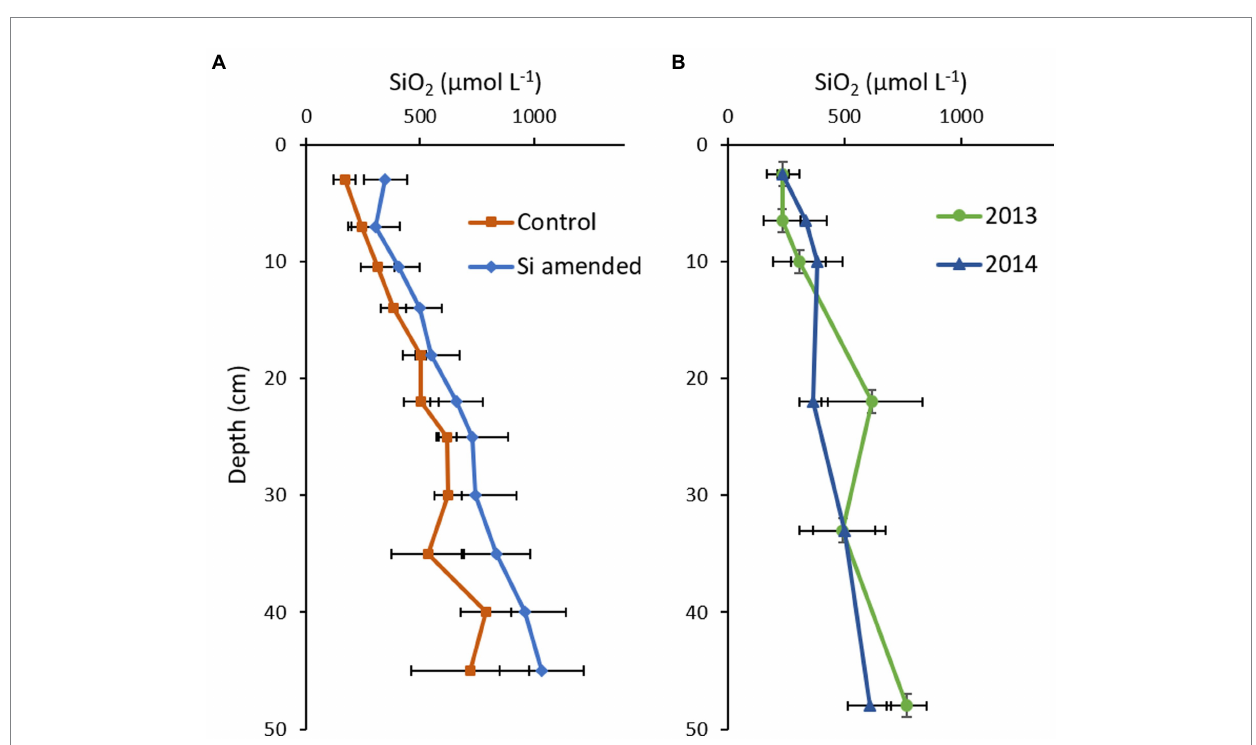
FIGURE 8 Mean porewater dissolved Si (DSi) concentration depth profiles measured in (A) 2012 in the Cell 1B experimental Si amendment (orange, n = 3) and unamended (blue, n = 3) plots; and (B) elsewhere in Cell 1B in 2013 (green, n = 3) and 2014 (blue, n = 5). Error bars represent standard deviation.